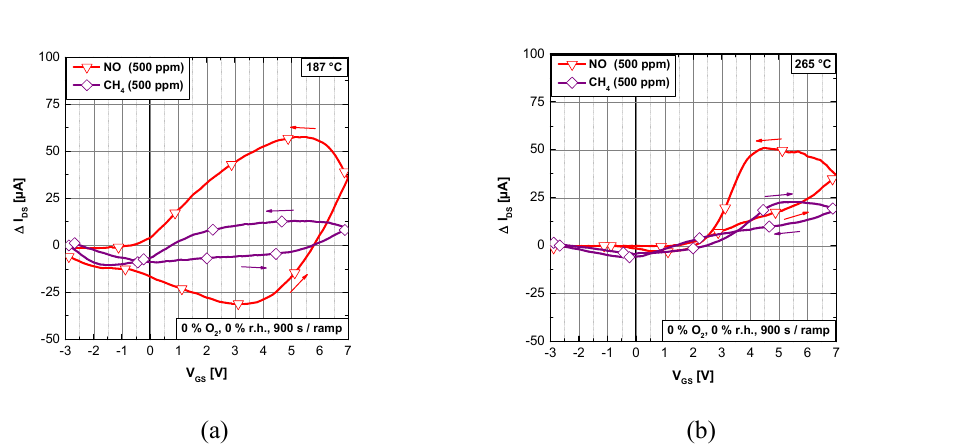
Figure 5. Hysteresis of ∆ I DS for 500ppm NO (red, triangles) and CH 4 (purple, diamonds) in dry nitrogen at 187 ◦ C (a) and 265 ◦ C (b) .